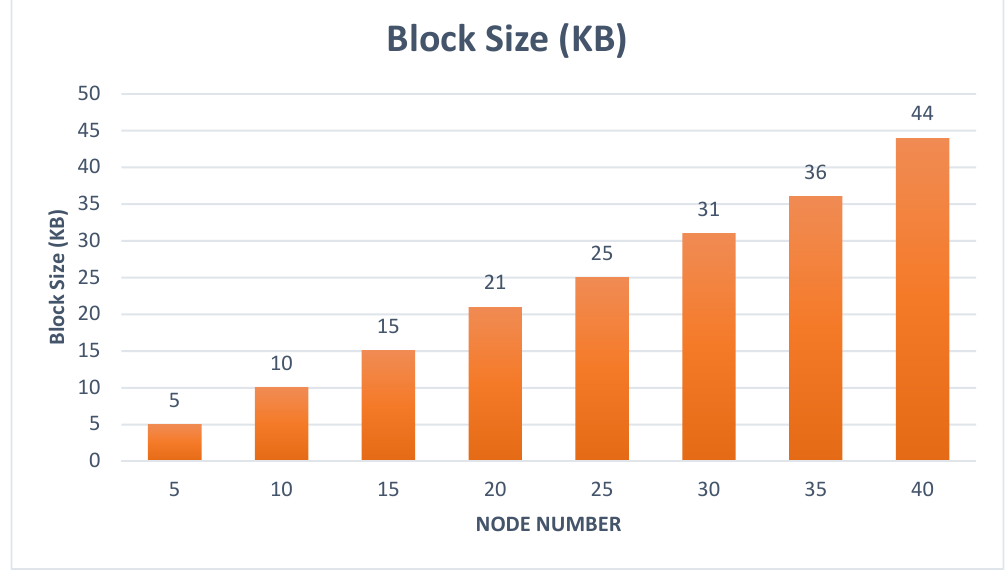
Figure 16. Block size of the blockchain-based system. After the performance values of the created blockchain-based system are obtained, in line with the three criteria decided before, the comparison of these values with the system without the blockchain layer begins. After the addition of the blockchain layer, it is seen that there is an increase in the verification times. The addition of the blockchain layer causes an increase in the verification time in the system (Figure 17).